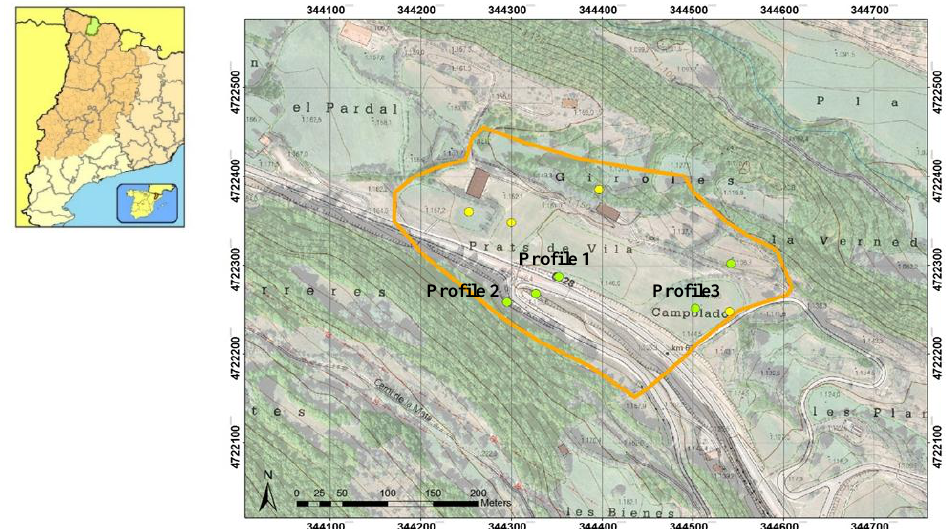
Figure 1. Location of the study site (València d’Àneu, Lleida). The characterized peatland is located 63 km from the C-28 road, between Prats de la Vila and Campolado. The yellow circles indicate the observations made in the field, while the green circles refer to the study pits.